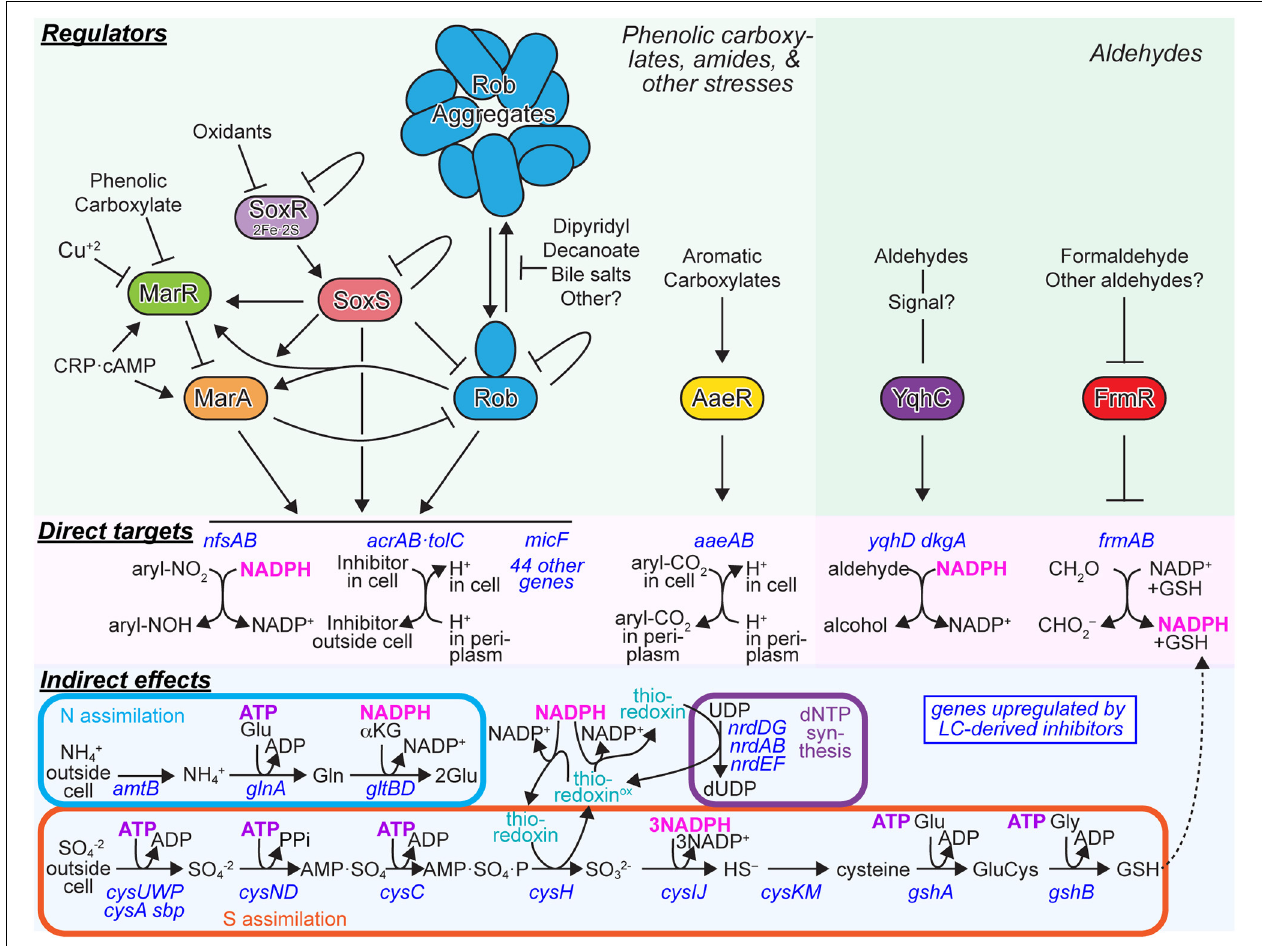
FIGURE 7 | Major Regulatory responses of E. coli to aromatic inhibitors found in ACSH. The major E. coli responses to phenolic carboxylates and amides (left) or responses to aldehydes (right) are depicted. Green panels , regulators and signaling interactions that mediate the regulatory responses.